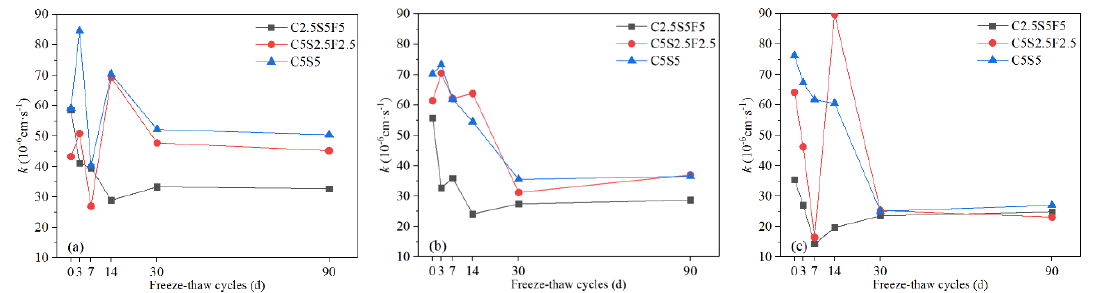
Figure 13. The k values of Pb-CSCSs with the same contaminant content and different compound binders: ( a ) 0.05% Pb 2+ ; ( b ) 0.5% Pb 2+ , and ( c ) 1% Pb 2+ .